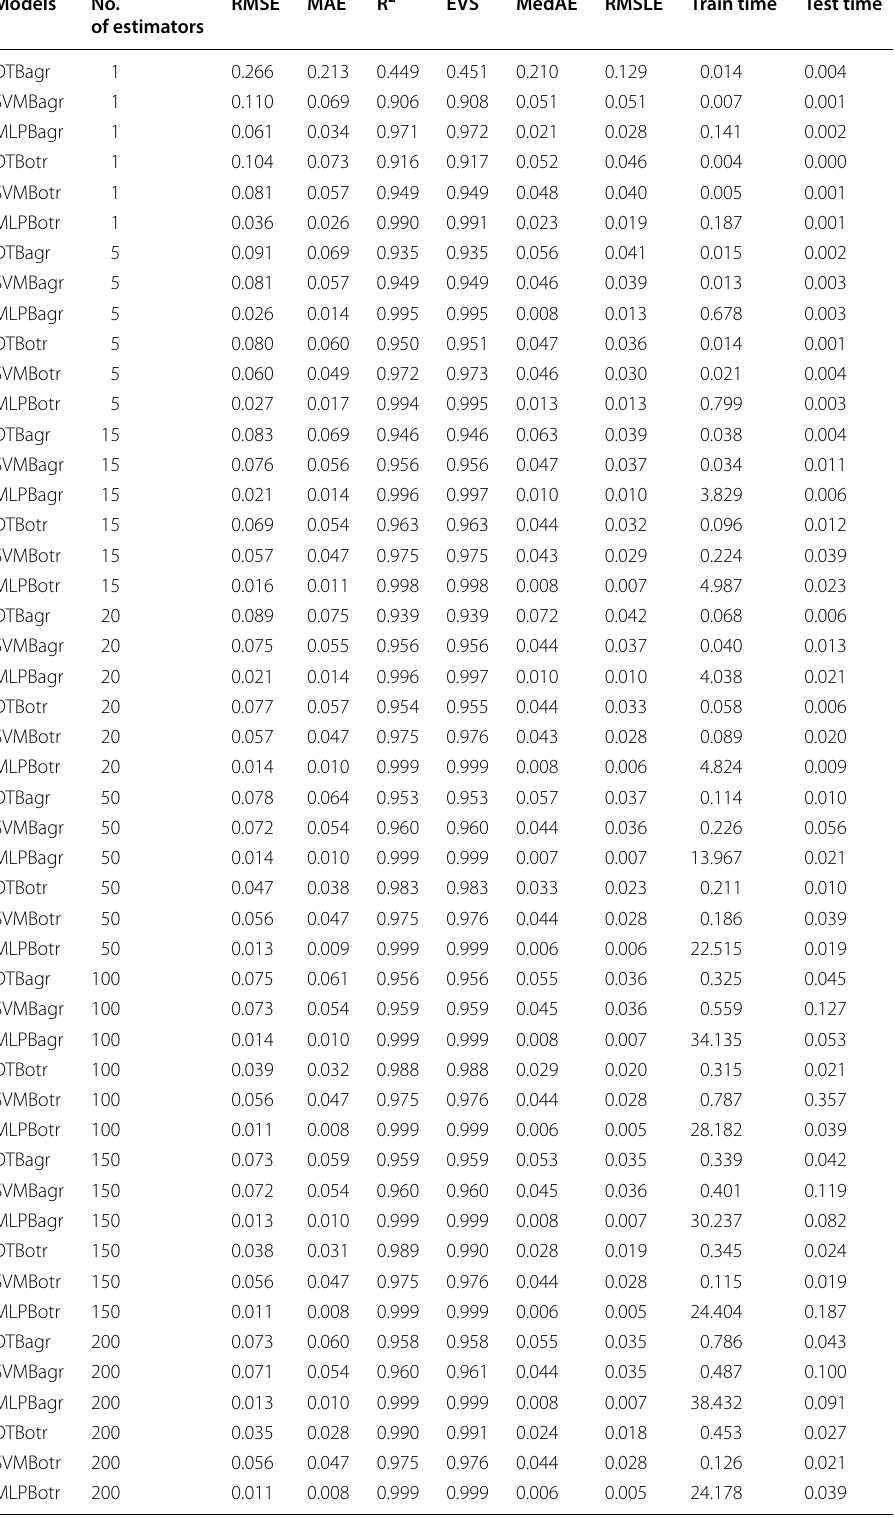
Table 16 Bagging and boosting ensemble regressors error metrics result over BSE dataset